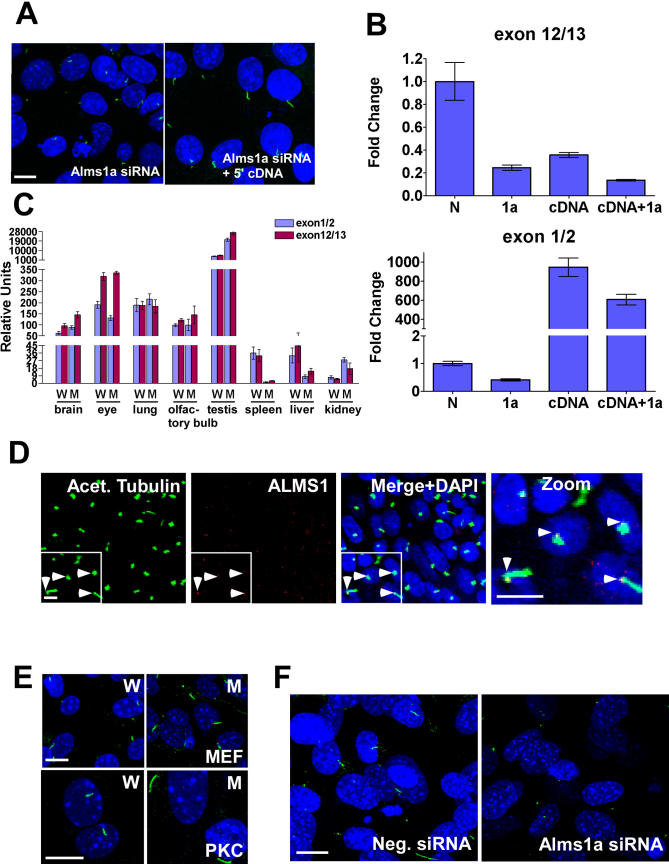
N-Terminal Alms1 Protein Can Support Cilia Formation(A) Cotransfection of Alms1a siRNA-treated cells with a 5′ Alms1 cDNA construct rescues primary cilia formation in mIMCD3 cells.(B) Real-time PCR analysis of Alms1a siRNA and N-terminal Alms1-transfected cells. Upper panel: over-expression of the 5′ cDNA does not affect knockdown of endogenous Alms1 mRNA with Alms1a siRNA. Lower panel: knockdown of endogenous Alms1 mRNA does not affect overexpression of the 5′ cDNA. N, negative control siRNA; cDNA, 5′ Alms1 cDNA; 1a, Alms1a siRNA.(C) Stable expression of Alms1 mRNA from the Alms1L2131X/L2131X allele. Real-time PCR analysis of Alms1 gene expression in an Alms1L2131X/L2131X mouse and a wild-type littermate control.(D) The N-terminal mouse Alms1 antibody detects Alms1 mutant protein at the ciliary basal body in primary kidney cells from the Alms1L2131X/L2131X mouse. Shown are low and high magnifications of the ciliated cells. Arrowheads point out the base of cilia.(E) Normal appearance of primary cilia in primary fibroblasts (MEF) and primary kidney cells (PKC) from the Alms1L2131X/L2131X mouse strain.(F) Inhibition of cilia formation in Alms1a siRNA-treated Alms1L2131X/L2131X primary fibroblasts. Scale bars, 10 μm.